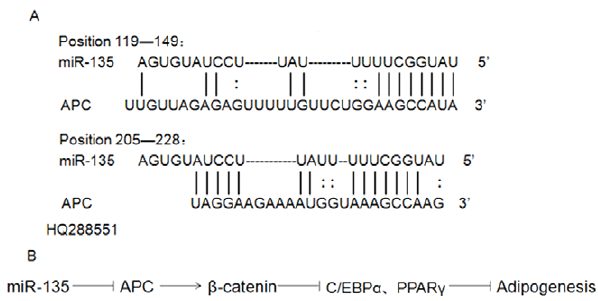
Figure 6. Hypothesis of miR-135 in porcine adipogenesis. A. 3 9 UTR of APC was predicted as a potential target of miR-135 (position and GenBank No. are listed). B. Potential regulation pathway of miR-135 in porcine adipogenesis.